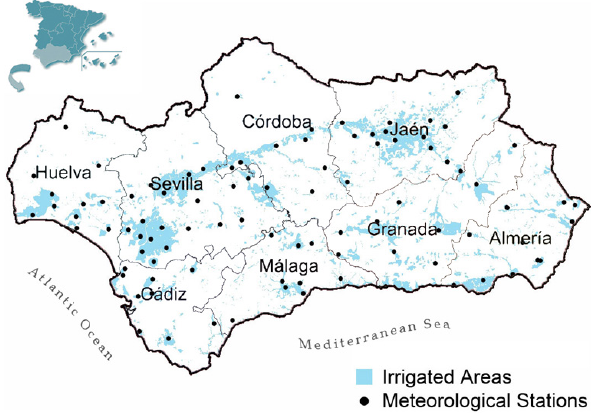
Figure 1. Agroclimatic Information Network of Andalusia (85 meteorological